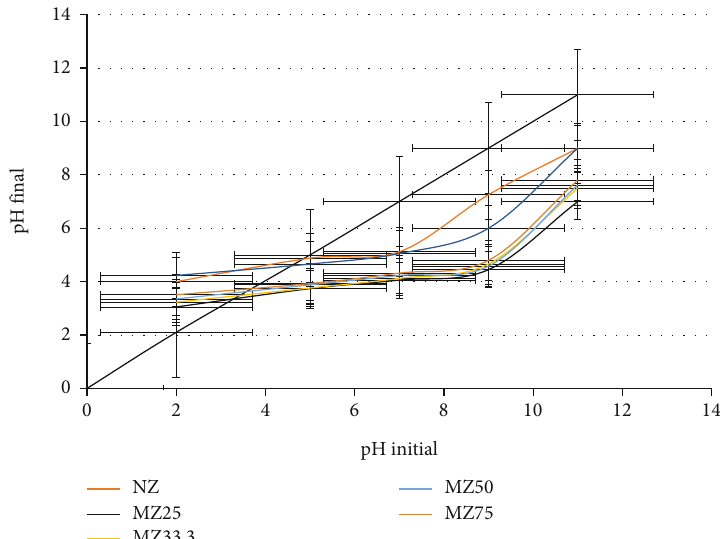
Figure 2: pH of zero charge of the natural and magnetic zeolites.